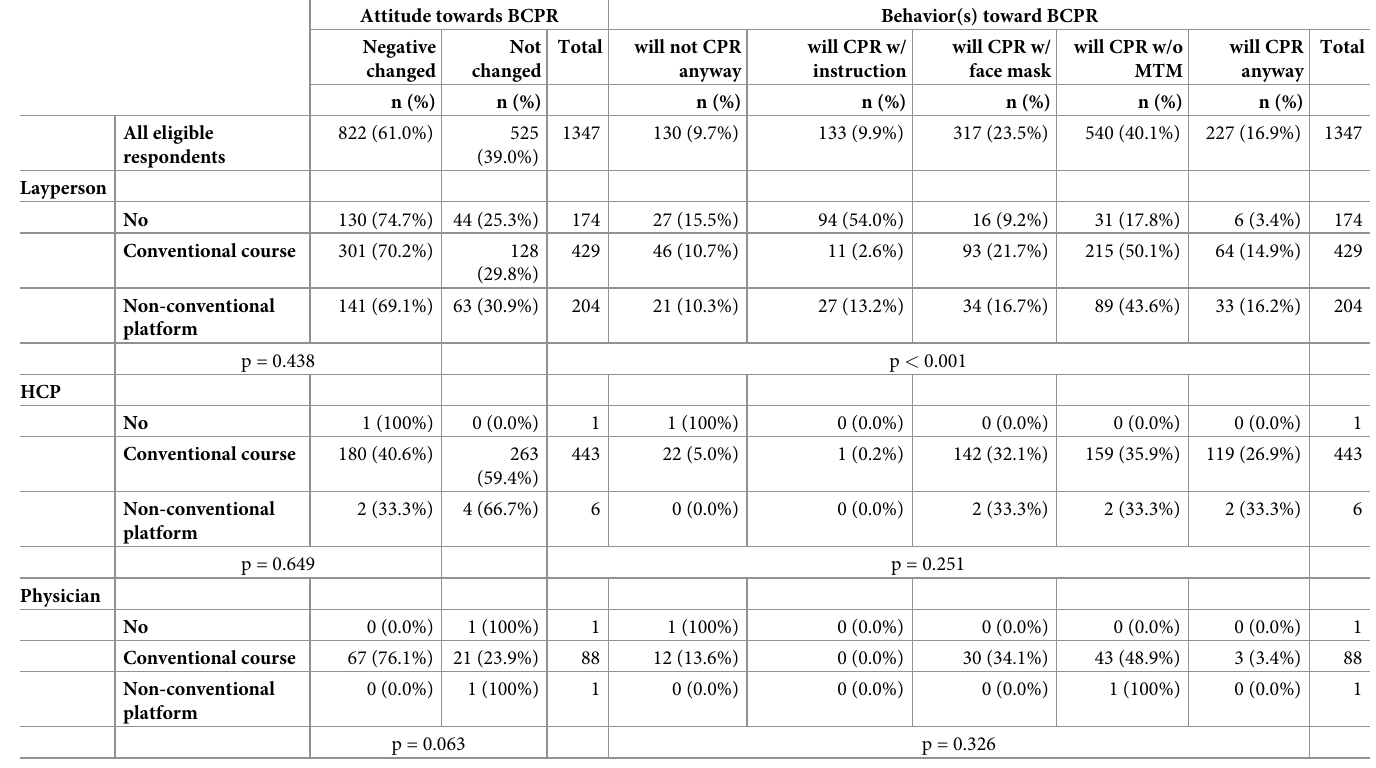
Table 4. Univariate association between pre-existing CPR training levels and willingness toward